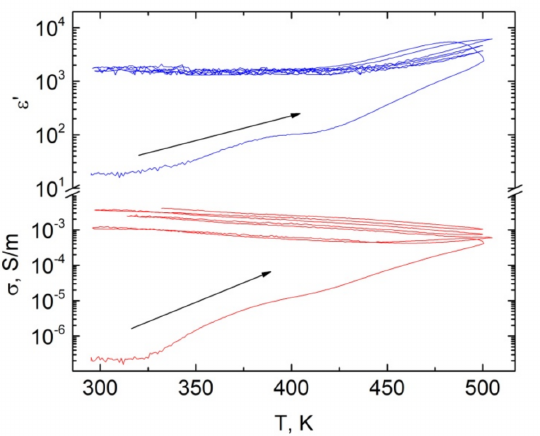
Figure 10. Temperature dependence of dielectric permittivity and electrical conductivity selected at 129 Hz for composite filled with 10 vol% Ni@C inclusions (multiple heating/cooling